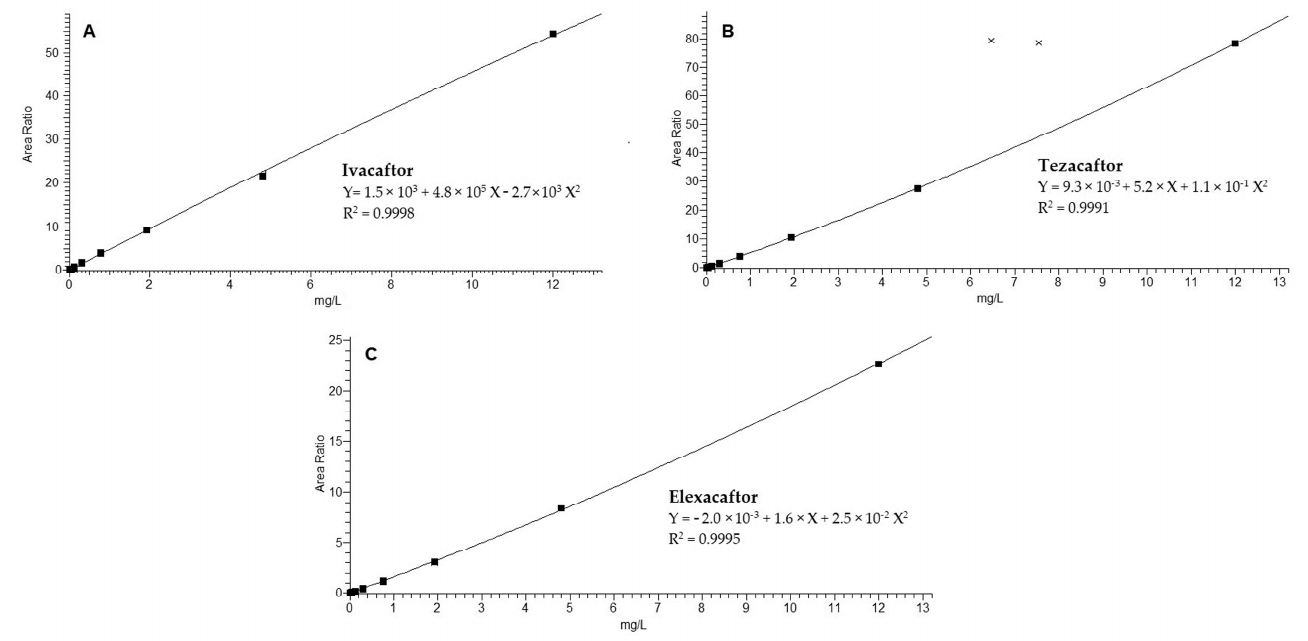
Figure 1. Chromatograms obtained: a calibrator at the LLOQ in plasma (panel 1.a, ivacaftor; panel 2.a, tezacafor, panel 3.a, elexacaftor); deuterated internal standards (panel 1.b, ivacaftor-d9, panel